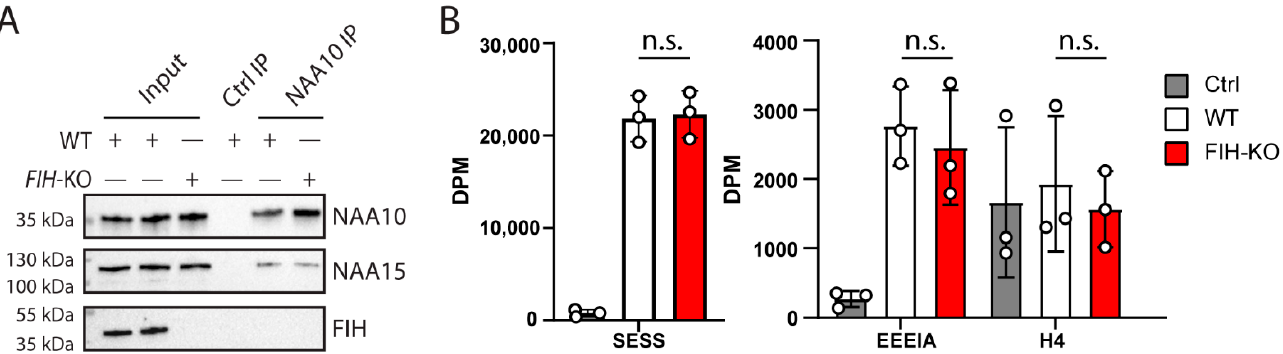
Figure 3. FIH does not influence the enzymatic activity of NAA10. ( A ) Immunoblots of the NAA10 IPs from HAP1-WT and HAP1- FIH- KO cells. ( B ) NatA and monomeric NAA10 activity measurement from 14 C-acetylation assay of immunoprecipitated NAA10 and coprecipitated NAA15. The activity towards SESS was normalized to NAA15, and the activity towards EEEI and histone 4 peptide was normalized to NAA10 to show relative product formation per enzyme. n.s., not significant (one-way ANOVA with Šídák correction for multiple testing).